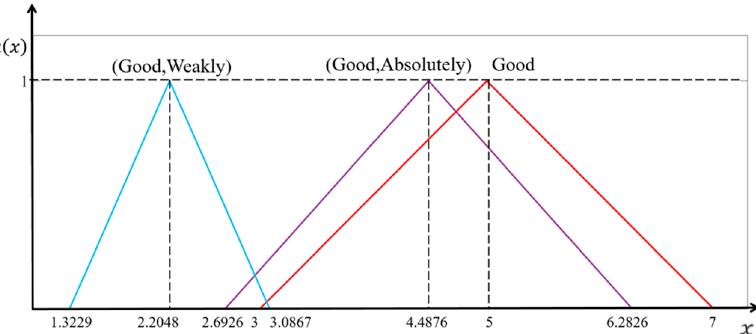
Figure 4. TFN of “good” corresponding to different confidence levels.